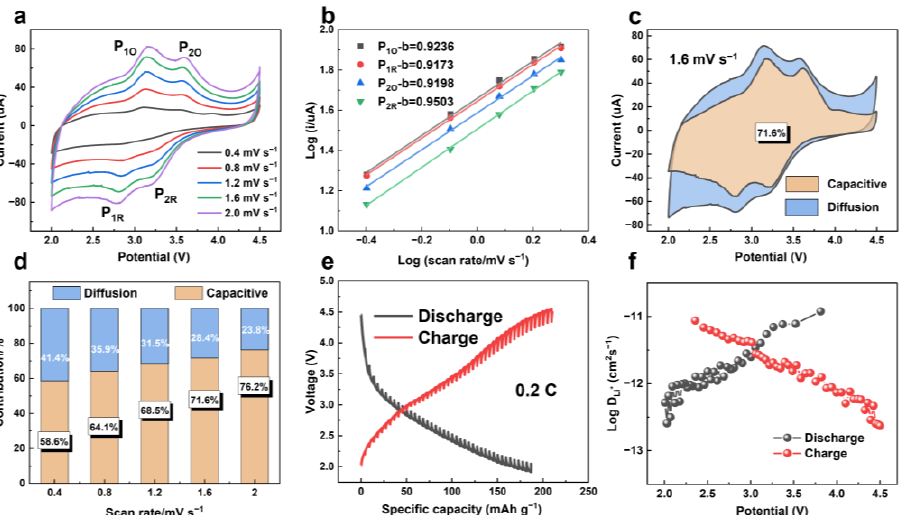
Figure 8. Kinetic features of the FeF 3 @C Na+ storage mechanism. ( a ) CV curves at the sweep rates of 0.4–2.0 mV s − 1 . ( b ) Determination of the b-value by the relationship between the characteristic peak current and different scan rates. ( c ) Percentage contribution of capacitive and diffusion to capacity in FeF3@C SIBs at 1.6 mV s − 1 . ( d ) Separation of capacitive contributions and diffusion-controlled contributions at different rates. ( e ) GITT charge-discharge curve of the second cycle at 0.2 C of FeF3@C SIBs. ( f ) Calculated Li+ diffusion coefficients at a different